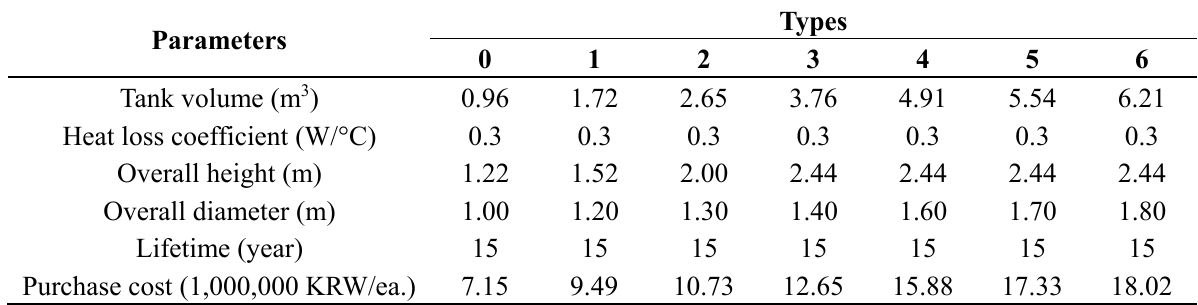
Table A4. Technical and economic parameters of the storage tanks for each case.